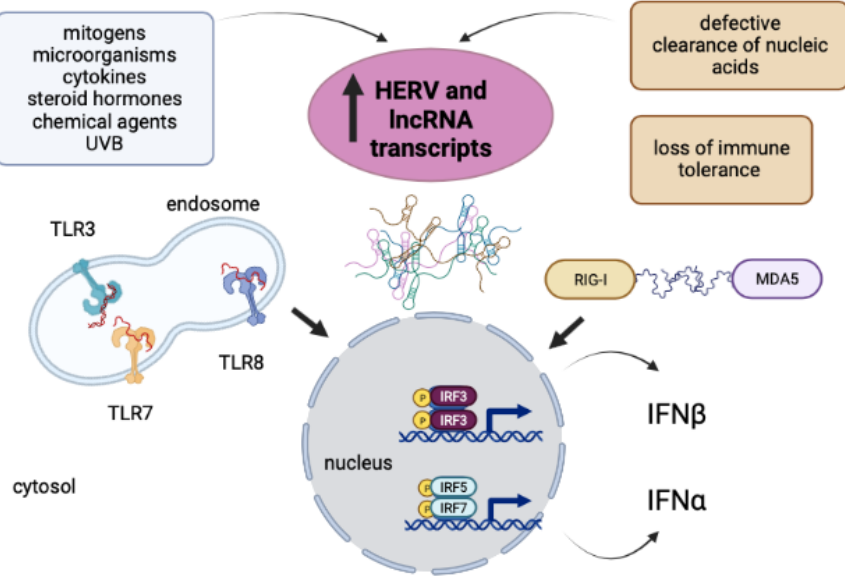
Figure 1. Cascade of events triggered by ncRNAs leading to type I IFN response in SLE. Under the stimulus of mitogens, microorganisms, proinflammatory cytokines, hormones, UVB, or chemical agents, the cells of SLE patients may overproduce ncRNA transcripts. Due to defective clearance of nucleic acids and the loss of immune tolerance that characterize SLE, ncRNAs may bind to RNA sensors such as TLRs, RIG-I, and MDA5 and contribute to the development of the type I IFN response and autoimmunity (HERV: human endogenous retrovirus; IFN: interferon; IRF: interferon regulatory factor; lncRNA: long noncoding RNA; MDA5: melanoma differentiation-associated gene 5; RIG-I: retinoic acid-inducible gene I; TLR: Toll-like receptor; UVB: ultraviolet B radiation). The figure was created with BioRender.com.